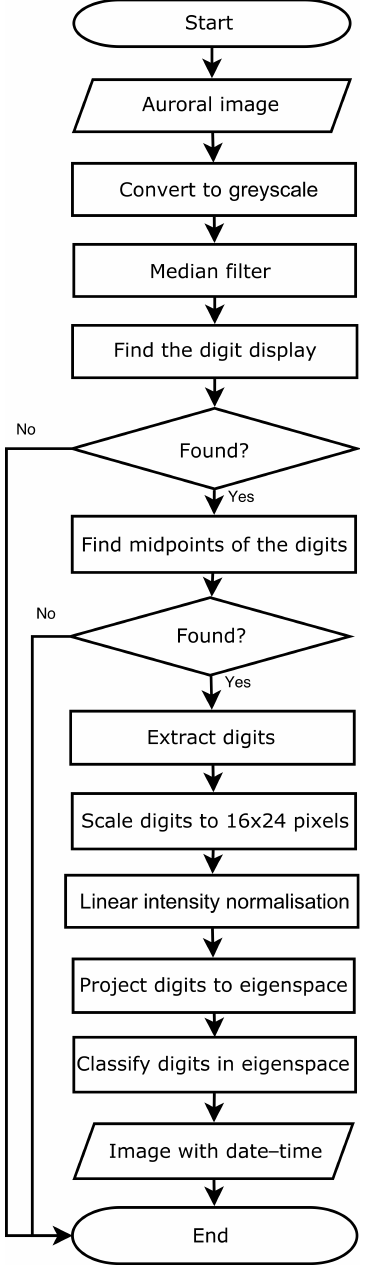
Figure 3. Flow chart of the classification process. Each individual image is converted to greyscale and median-filtered before finding and extracting the clock display digits. Detected digits are scaled in size and normalised in intensity prior to the number classification.